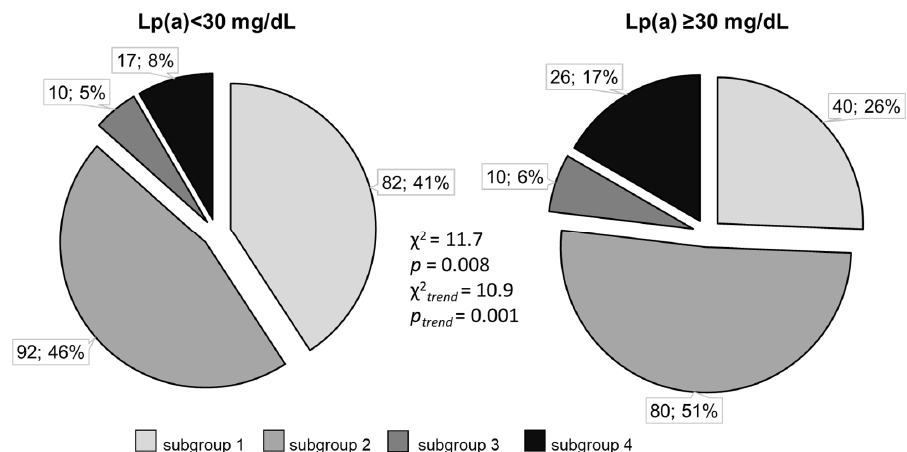
Figure 2. Distribution of different types of coronary artery lesions depending on the Lp(a) concentration. Subgroup 1—segmental lesion without calcinosis, subgroup 2—diffuse lesion without calcinosis, subgroup 3—segmental with calcification, subgroup 4—diffuse with calcinosis. In the subgroup of patients with diffuse lesions and calcinosis, the level of LDL-C was significantly higher than that in patients with segmental lesions alone (Figure 3a), but the significance of differences disappeared when analyzing LDL-Ccorr, which takes into account the concentration of cholesterol in Lp(a) (Figure 3b).